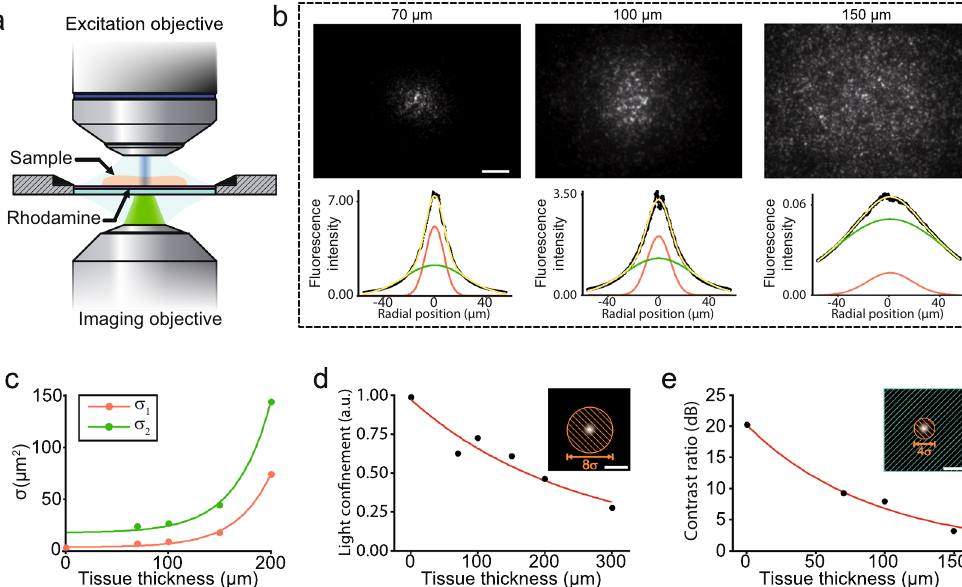
Figure 2. Characterization of low-NA Gaussian beam propagation through brain slices. ( a ) Two objectives positioned in opposed direction and focused on the sample plane to form a double microscope. This configuration enables high resolution imaging of the speckle patterns formed after beam propagation. In this case, a low-NA Gaussian beam exits the upper objective and propagates through a brain slice of a certain thickness towards a thin fluorescent layer placed beneath the sample. The emitted fluorescence is collected by the bottom objective and imaged on a CCD camera. ( b ) Upper panel images represent the spatial distribution of light on the rhodamine layer after propagating through brain slices of 50, 100 and 150 µ m thicknesses, respectively. The graphs below represent a radial distribution of light. Dotted black line represents the experimental data fitted with curve (yellow line) resulting from the addition of two Gaussian curves (red and green lines) with different amplitude and standard deviation. The variation of the relative amplitude and standard deviation of the two Gaussians with sample thickness suggest that the two components are mostly related to ballistic or single scattering photons (red line) and multiple scattering photons (green line). Scale bar; 10 µ m. ( c ) Degradation of the lateral precision with depth seen as the variation on the standard deviation of the Gaussian curves. ( d ) Normalized integrated fluorescence intensity within a 8 σ 1 -dimenter disk for different tissue thicknesses. ( e ) Ratio between integrated fluorescence intensity within a 4 σ 1 -diamenter disk (orange area) and the integrated fluorescence intensity on the outer area (green area) for different tissue